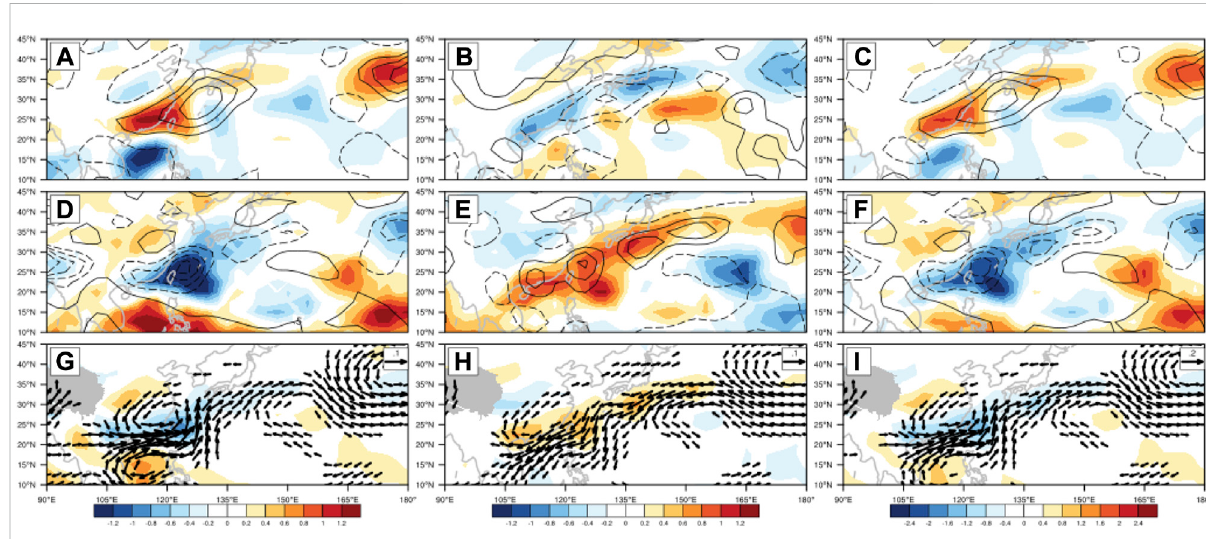
FIGURE 4 Top row: composite 30 – 90 days fi ltered 850 hPa vorticity anomalies (shaded, unit : 10 − 6 s − 1 ) and 200 hPa divergence anomalies (contours, unit : 10 − 7 s − 1 ). Middle row: composite 30 – 90 days fi ltered outgoing longwave radiation anomalies (OLR, shaded, unit : Wm − 1 ) and 500 hPa omega anomalies (contours, unit : 10 − 3 Pas − 1 ). Bottom row: composite 30 – 90 days fi ltered water vapor fl ux (vectors, unit : kgm − 1 s − 1 ) vertically integrated from 1,000 to 500 hPa and its divergence (shaded, unit : 10 − 5 kgm − 2 s − 1 ). (A,D,G) for P2 positive years, (B,E,H) for P2 negative years, and (C,F,I) are the differences between composites of positive years and negative years. Only values signi fi cant at/above the 95% con fi dence level by Student ’ s t test are shown. The dashed lines indicate values greater than zero while solid lines indicate values less than zero in (A – F)